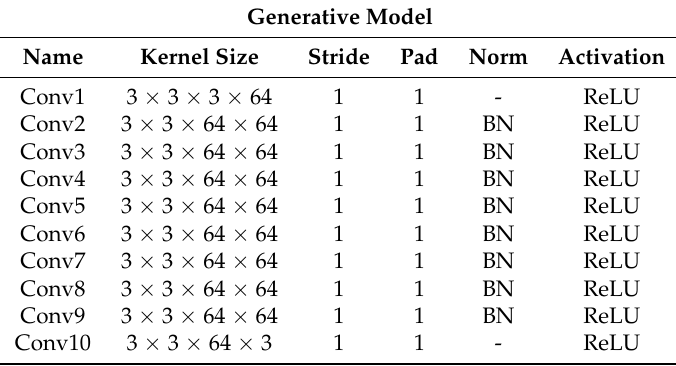
Table 1. Generative model network architectures. Conv means convolutional layer; BN means batch normalization; ReLU means rectified linear